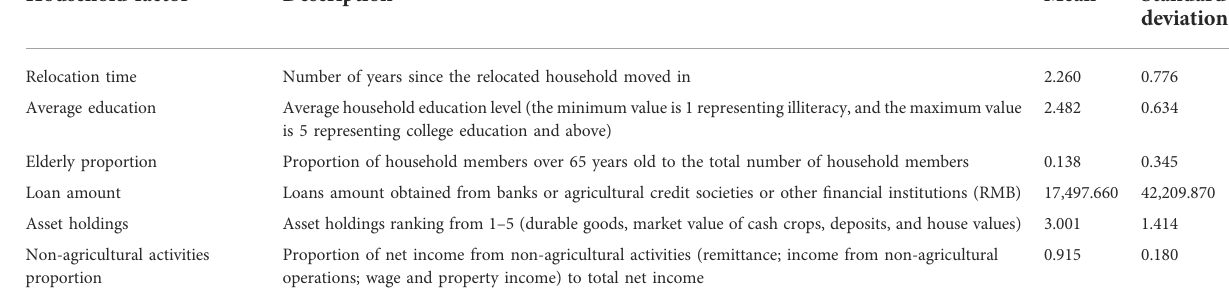
TABLE 5 Description and statistics for household